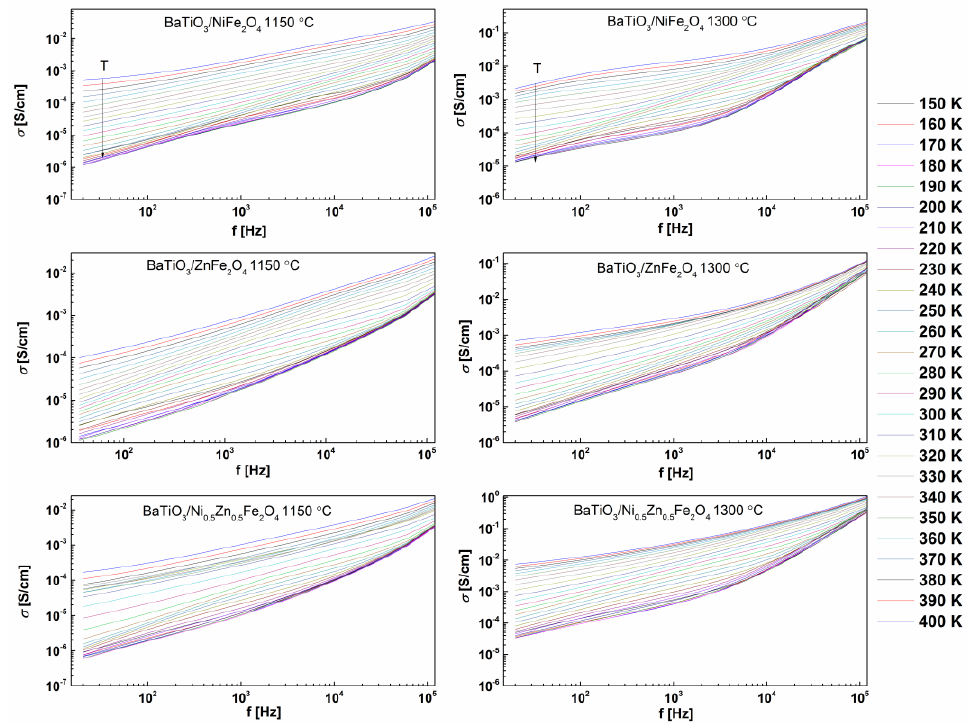
Figure 10. Conductivity spectra of the sintered samples and their temperature dependence.